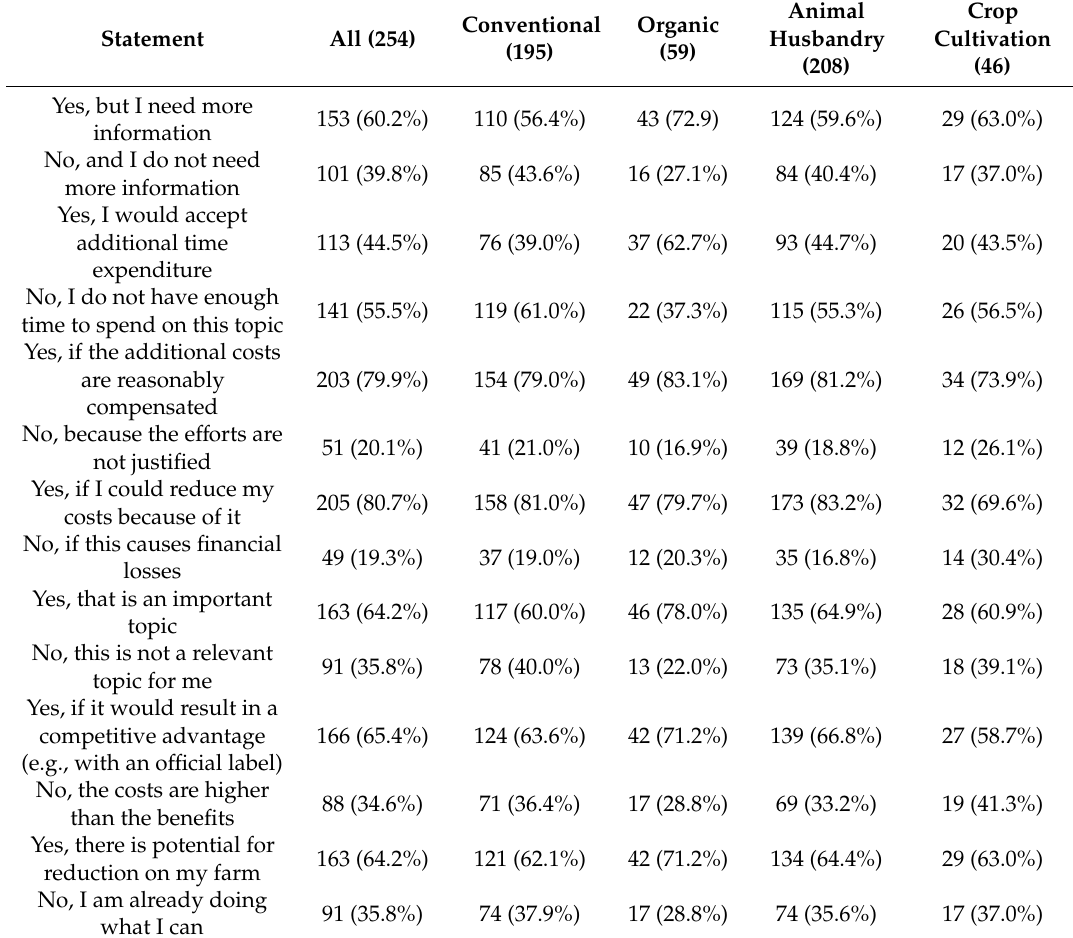
Table 1. German farmers’ positions towards on-farm greenhouse gas emission (GHG)